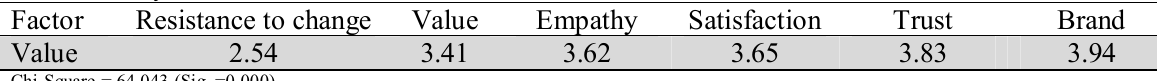
The summary of Freedman test Factor Resistance to change Value Empathy Satisfaction Trust Brand Value